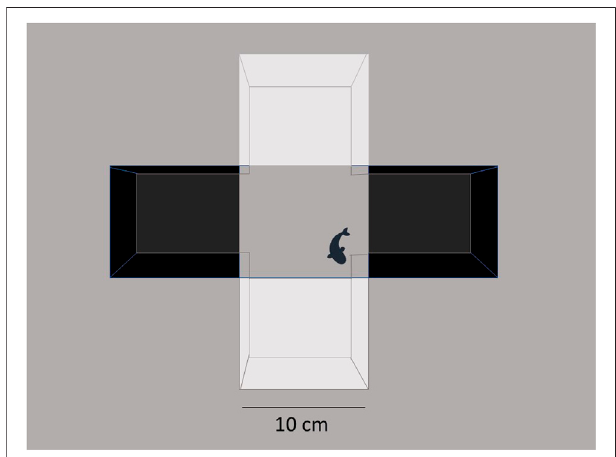
FIGURE1 | Light/dark plus maze. The aquatic cross maze is set up with a 3 × 3 box con fi guration at the intersection of the maze. Fish explore the environment under bright light (800 lumens from a 60 W bulb), and the behavior is video-recorded for 5 min. Treatment-blind observers collect data on time spent in different areas of the